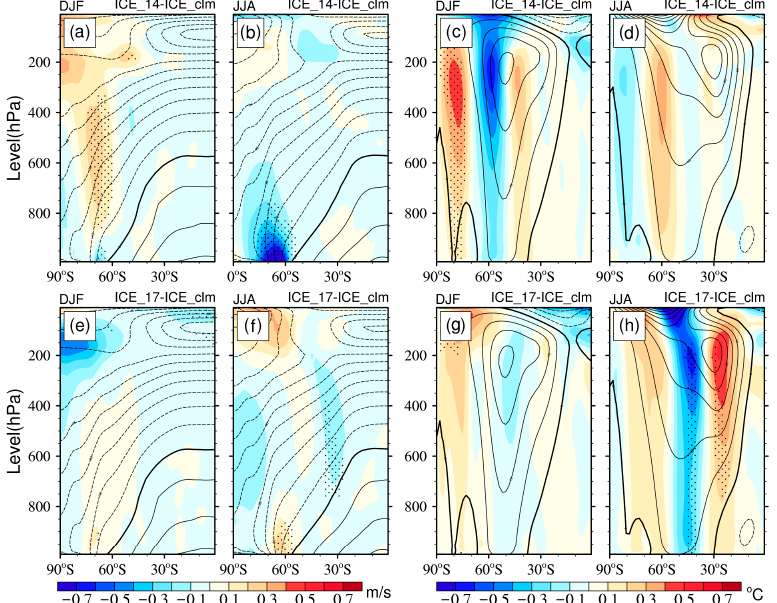
Figure 3. Changes in the zonal mean temperature and zonal winds as a result of changes in Antarctic sea ice. The zonal mean temperature ( a , e ) in summer and ( b , f ) in winter. The zonal mean zonal wind in ( c , g ) summer and ( d , h ) winter. Parts ( a – d ) show the differences between ICE_14 and ICE_clm; ( e – h ) show the differences between ICE_17 and ICE_clm. The dotted areas were statistically significant at the 95% confidence level. The contours represent the mean state of ICE_clm. Atmosphere 2023 , 14 , 36